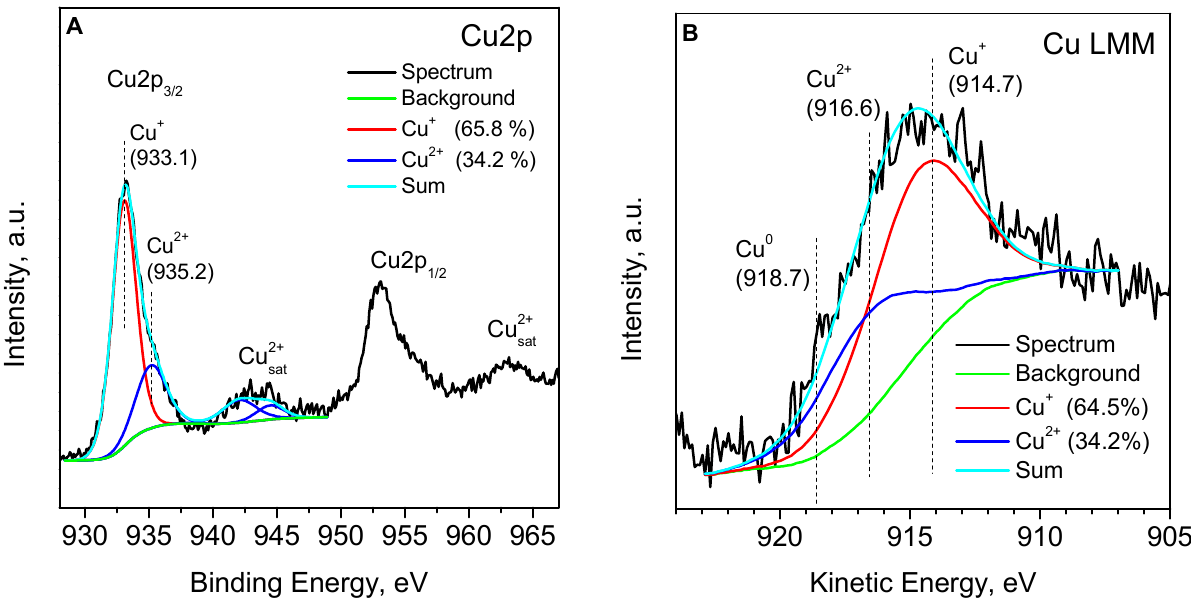
Figure 3. XPS spectrum of Cu 2p ( A ) and Cu LMM ( B ) for the 6.4CuZ27(SE) sample.